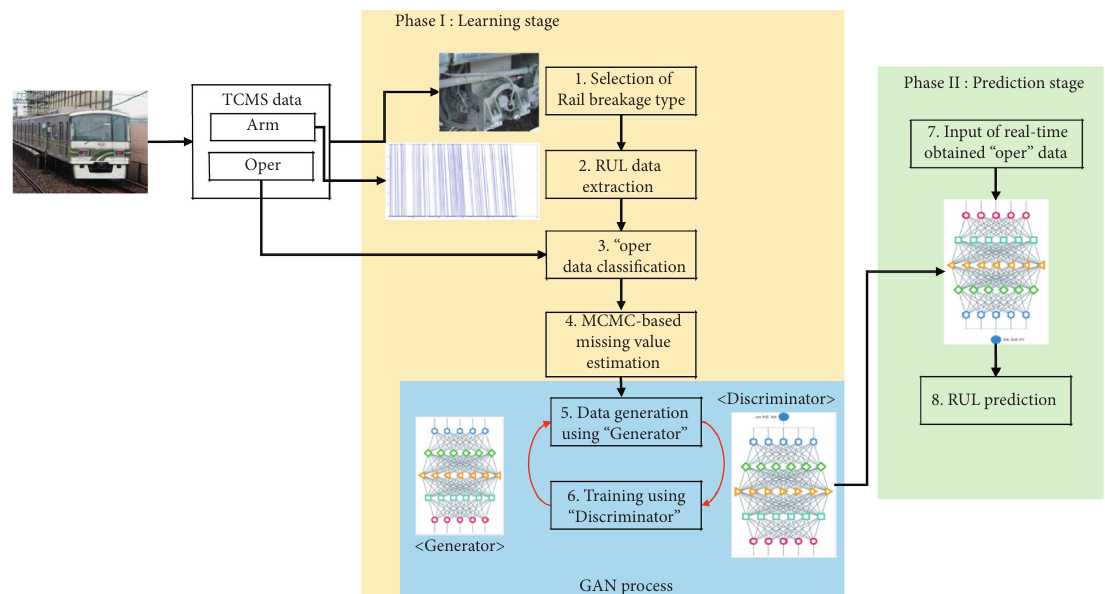
Figure 5: GAN-based missing value handling and RUL prediction